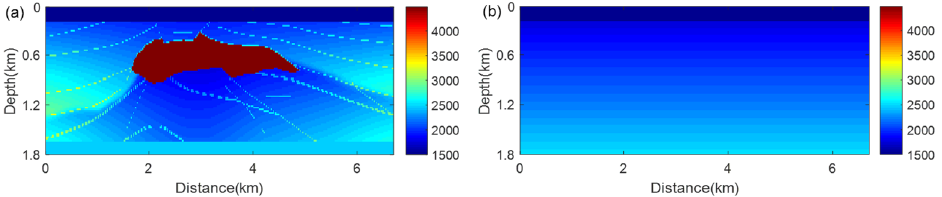
Figure 4. True and initial velocity model. ( a ) The true velocity model with a strong scattering salt body. ( b ) The initial velocity model without any salt information.